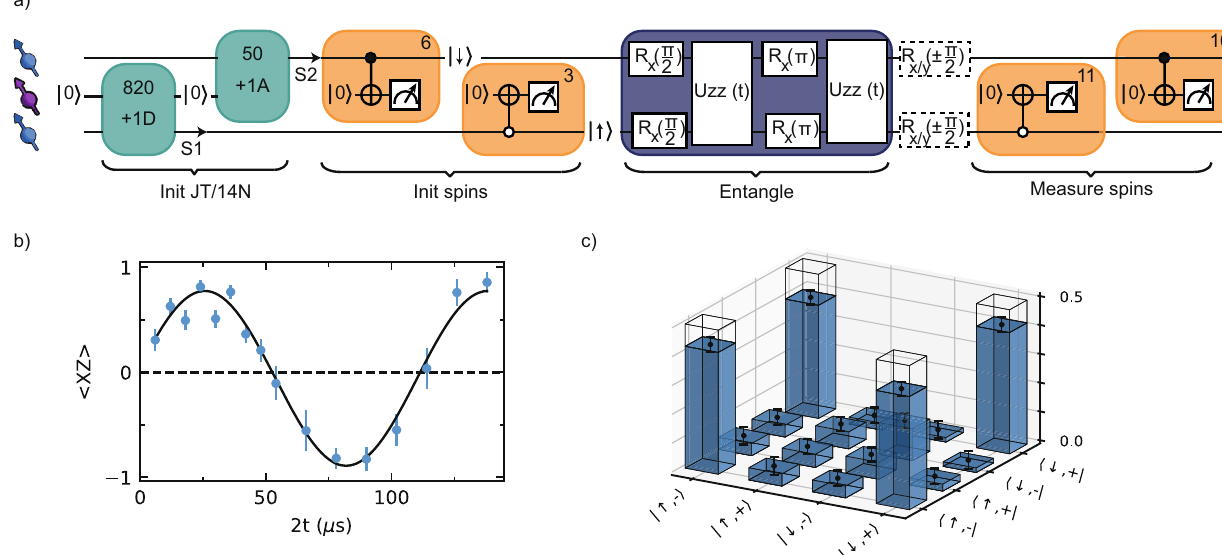
Fig. 6 Entanglement between two P1s. a Experimental sequence to measure coupling and generate entanglement between S1 and S2. DEER measurements initialize the JT axis and nitrogen state of S1 and S2 ( K = 820, 50, and f = f + 1D , f + 1A ), followed by DEER(y) measurements to initialize their electron spin states ( L = 6, 3). Two π /2 pulses and an evolution for time 2 t under a double echo implements the S z S z interaction with both spins in the equatorial plane of the Bloch sphere. This is followed by single-qubit gates (dashed boxes) for full two-qubit state tomography and two fi nal DEER(y) measurements for electron spin readout. We apply an additional initial sequence ( K = 5, f + 1A ) to speed up the experiment (not shown in sequence, see Supplementary Note 15). b The coherent oscillation of 〈 XZ 〉 as a function of interaction time 2 t demonstrates a dipolar coupling J = − 2 π ⋅ 17.8(5) kHz between S1 and S2. c Density matrix of the S1 and S2 electron spins after applying the sequence as shown in a for 2 t = π / J . The fi delity with the target state is F = 0.81(5). Transparent bars indicate the density matrix for the target state Ψ j i . All error bars indicate one statistical standard